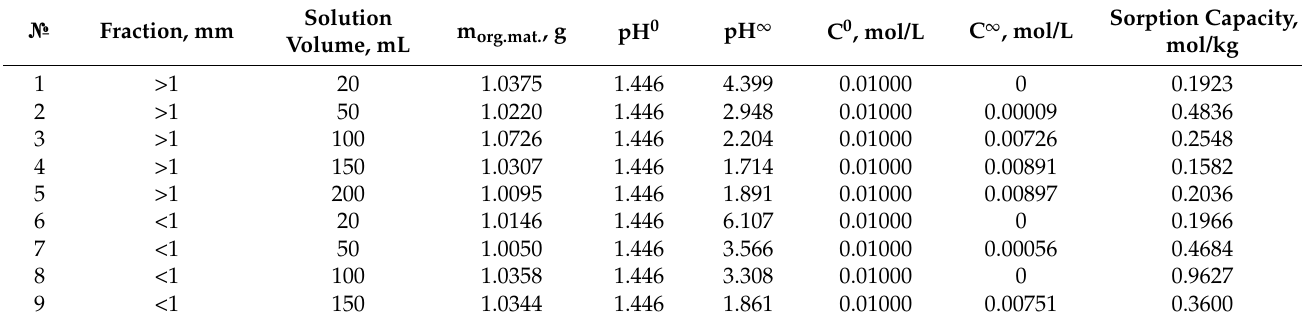
Table 6. Results of Fe 3+ sorption by organic material.